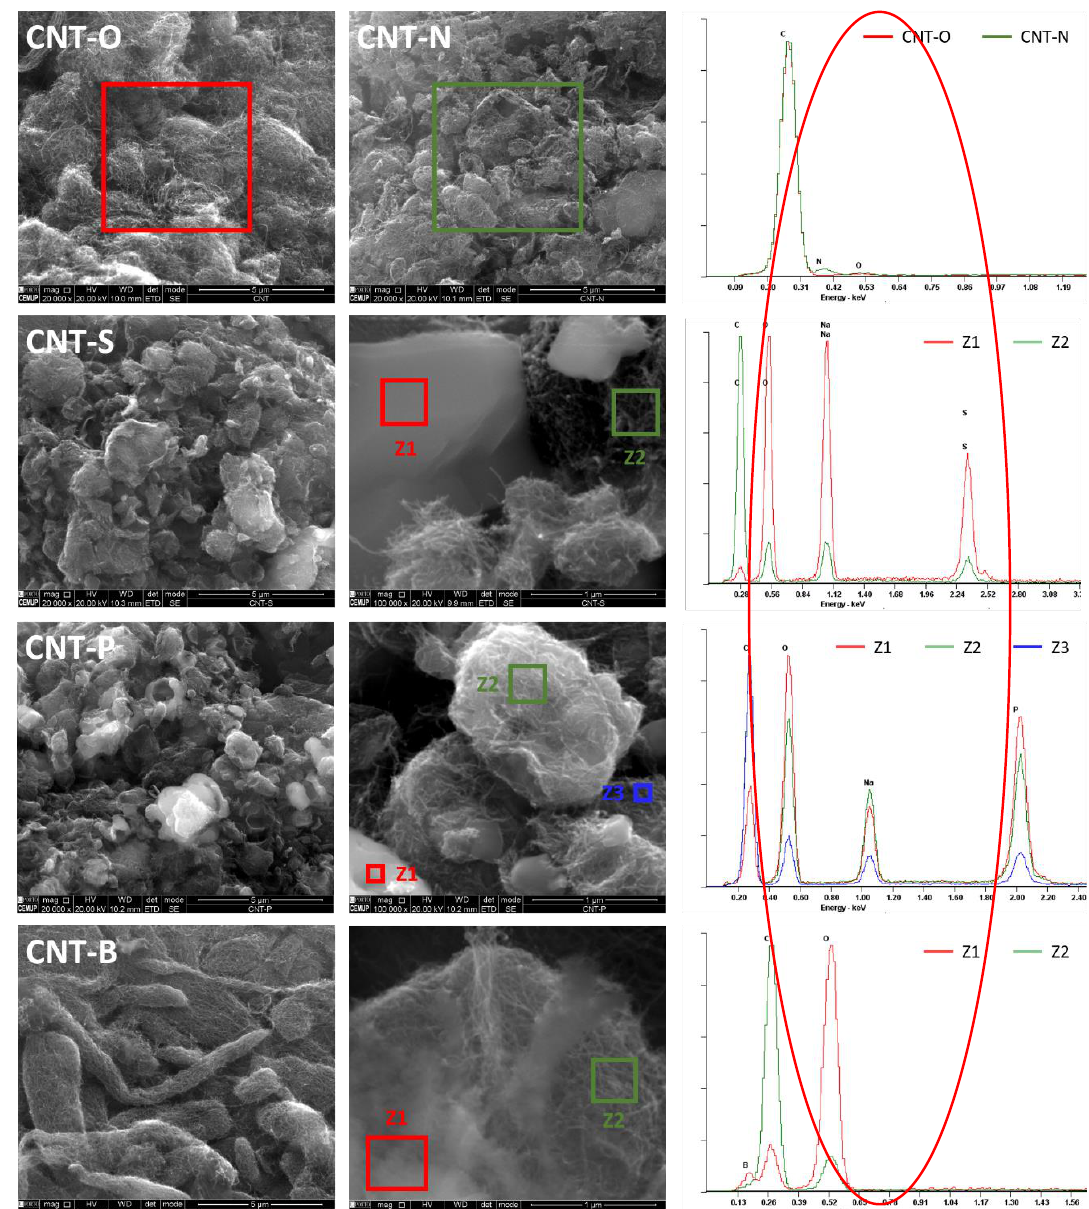
Figure 5. Scanning electron microscopy (SEM) images and Energy Dispersive X-ray Spectroscopy (EDS) analysis of the doped samples.